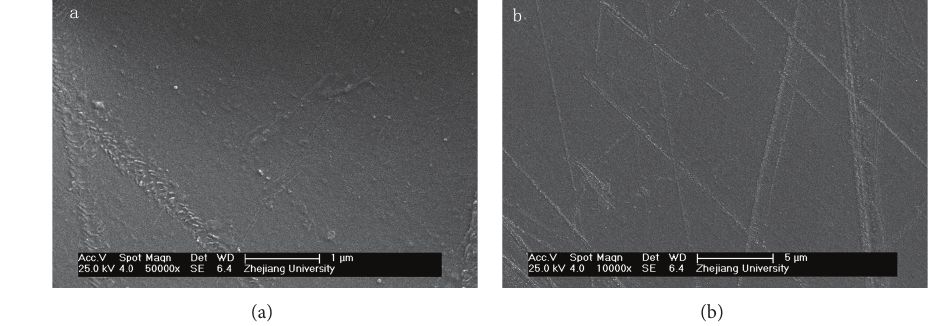
Figure 2: FESEM micrographs of the DLC films on PET.